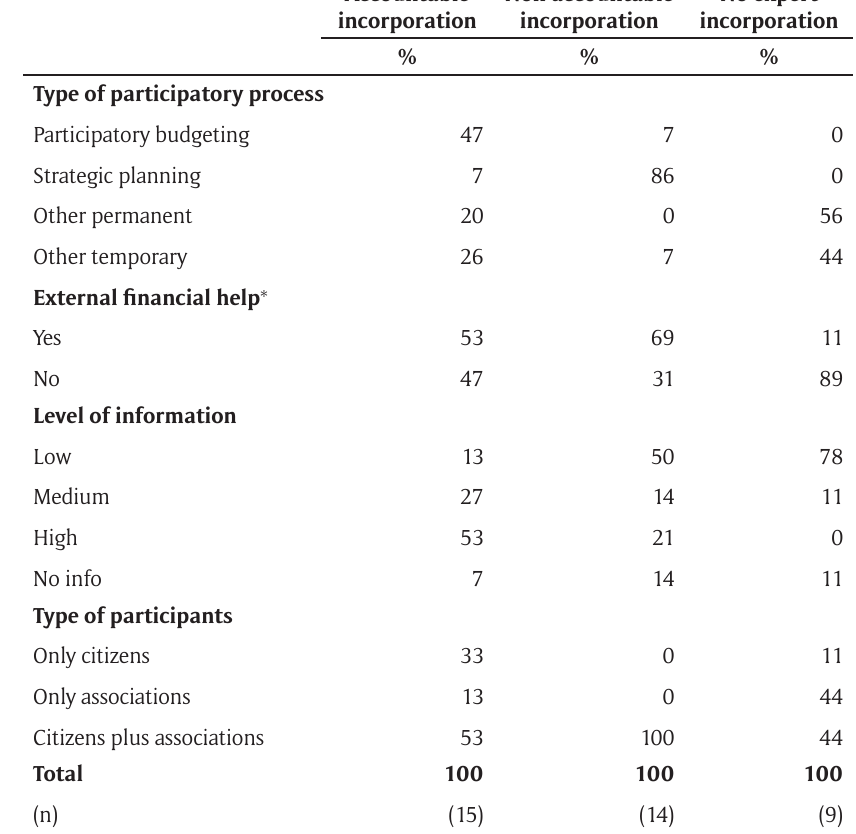
Table 3: Process characteristics and incorporation of expertise (%